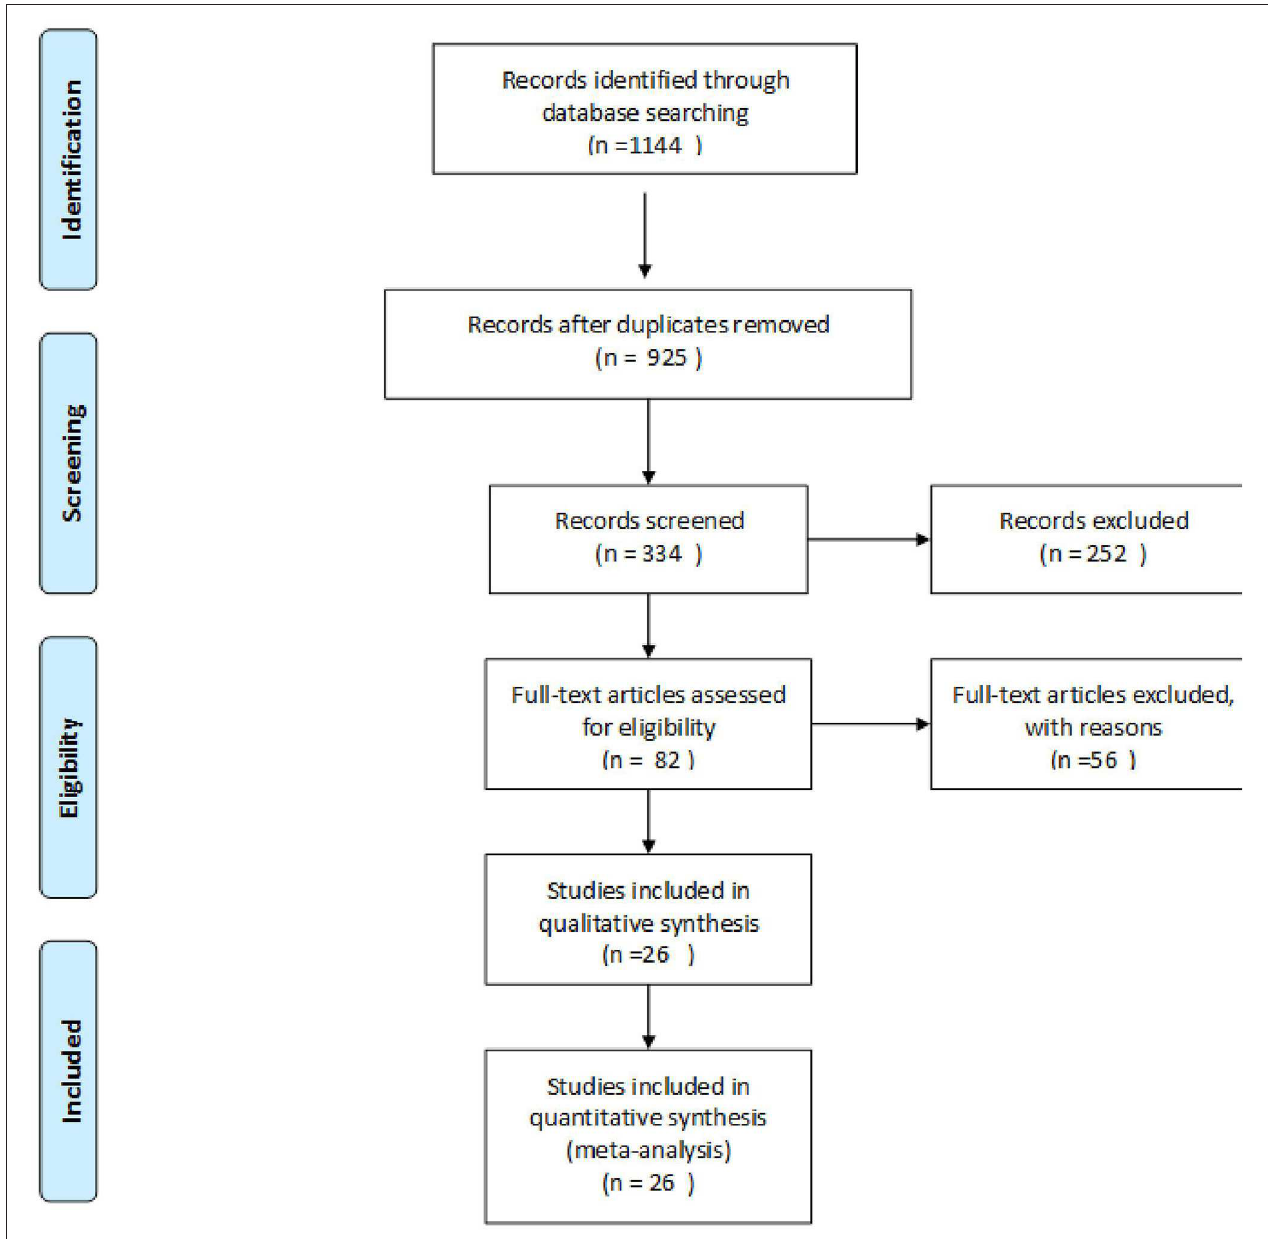
FIGURE 1 | Flowchart of the search and selection process.